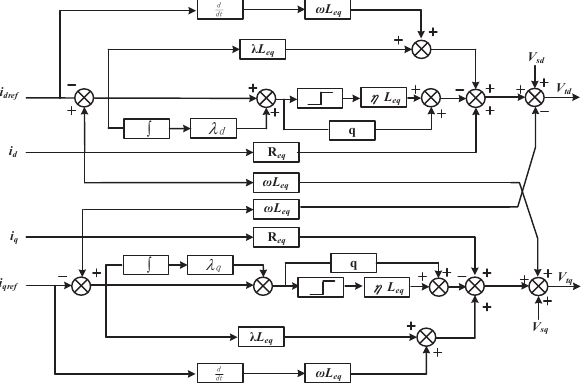
Figure 7. The current controller of MMC based on the proposed method.